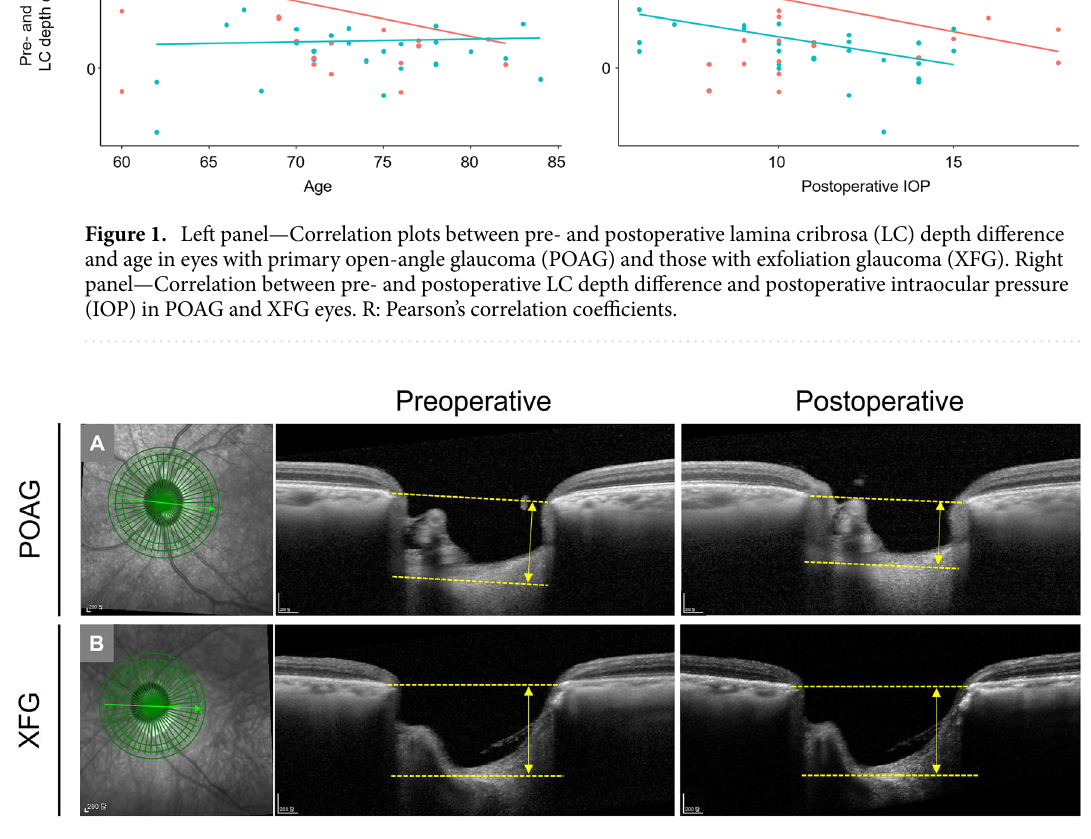
Figure 2. Representative cases of pre- and post-operative lamina cribrosa (LC) depth changes in POAG ( A ) and XFG ( B ) eyes. ( A ) 77-year-old male. Axial length (AL) 25.1 mm. Visual field mean deviation (MD) − 21.9 dB. Significant LC depth shallowing is observed from 775 µm preoperatively (IOP 27 mmHg) to 665 µm postoperatively (6 months. IOP 10 mmHg). ( B ) 76-year-old male. AL 24.3 mm. MD − 22.4 dB. LC depth is 911 µm preoperatively (IOP 27 mmHg) and 889 µm postoperatively (6 months. IOP 11